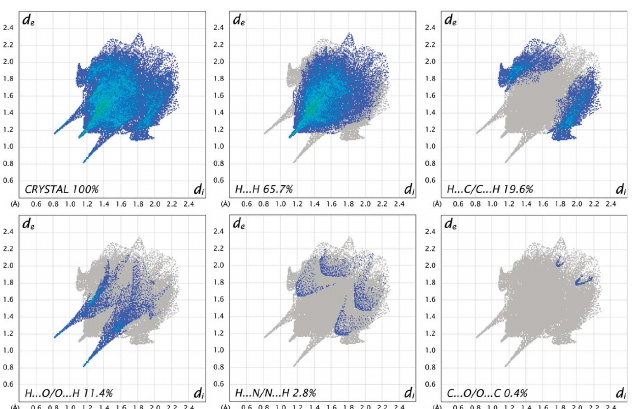
Figure 6 The full two-dimensional fingerprint plots for the rac -2 polymorph, showing all interactions, and delineated into H (cid:2)(cid:2)(cid:2) H, H (cid:2)(cid:2)(cid:2) C/C (cid:2)(cid:2)(cid:2) H, H (cid:2)(cid:2)(cid:2) O/O (cid:2)(cid:2)(cid:2) H, H (cid:2)(cid:2)(cid:2) N/N (cid:2)(cid:2)(cid:2) H, C (cid:2)(cid:2)(cid:2) O/O (cid:2)(cid:2)(cid:2) C interactions. The d i and d e values are the closest internal and external distances (in A˚ ) from given points on the Hirshfeld